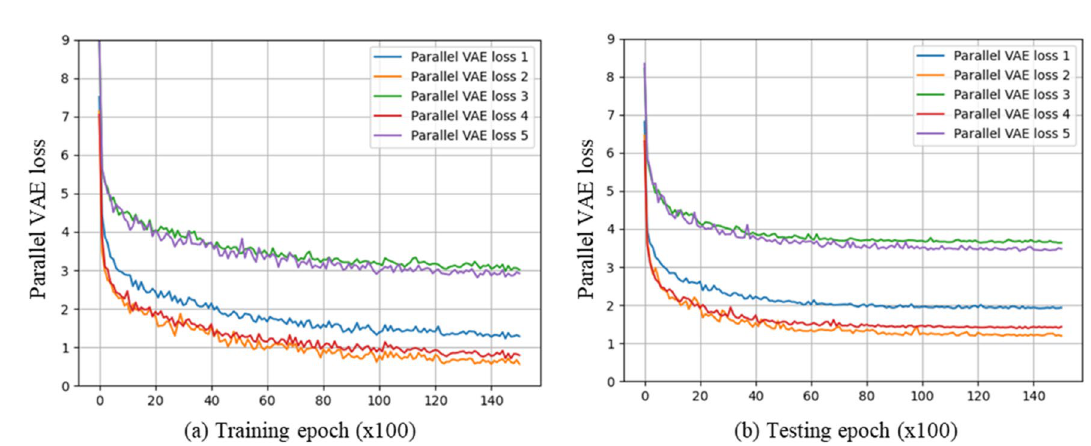
Figure 4. Results of the five combinations of weight values on parallel VAE loss values: ( a ) effects on parallel VAE loss during training and ( b ) effects of inputting test images to the model on parallel VAE loss values during